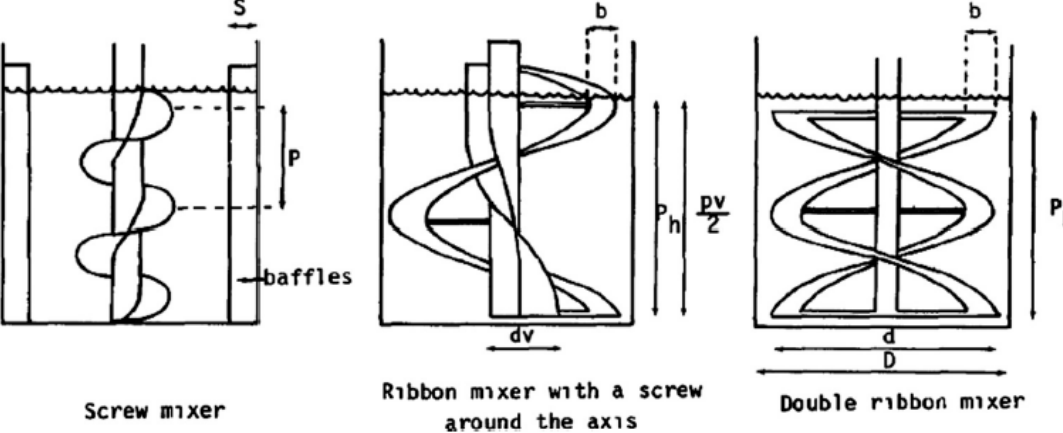
Figure 7. Ribbon mixer with a screw around the axis, screw mixer with four baffles, and double ribbon mixer propellers. Reproduced with permission from reference [83].